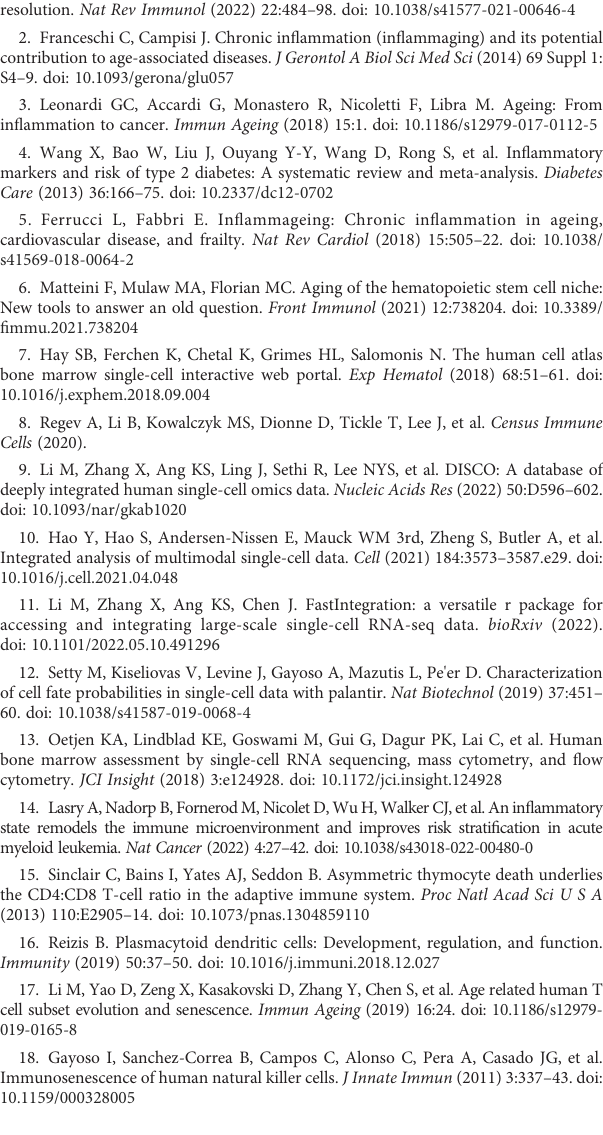
SUPPLEMENTARY TABLE 1 Data sample metadata.